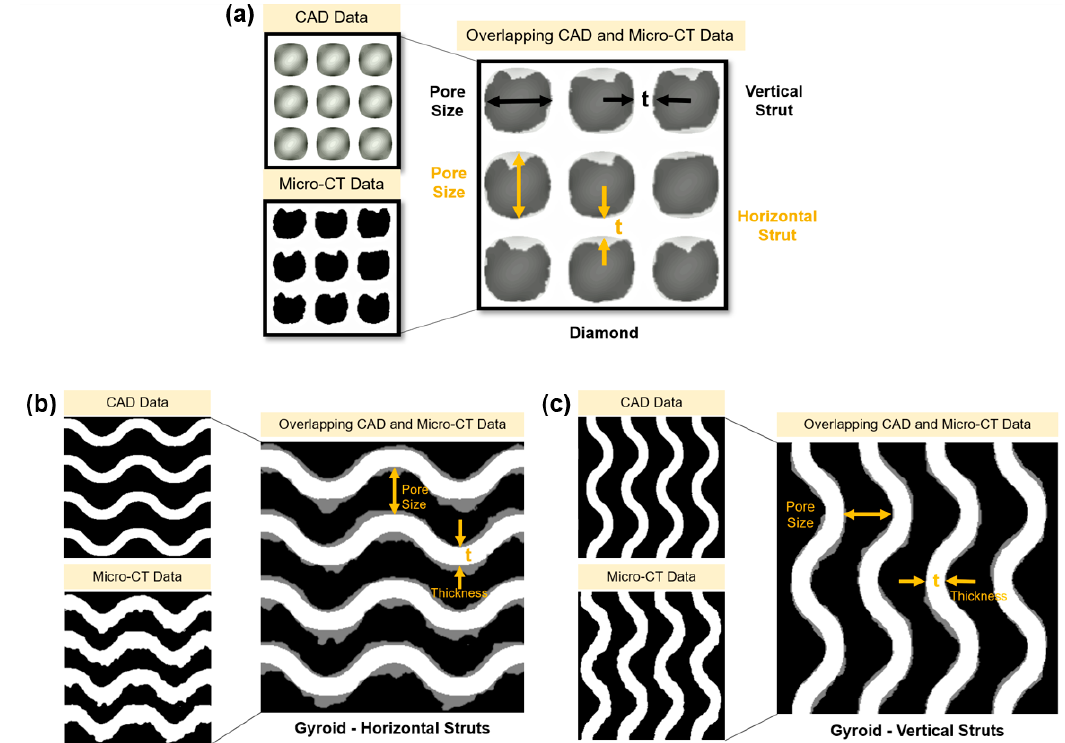
Figure 5. Overlapping CAD and micro-CT morphology data in vertical and horizontal struts orientations for ( a ) diamond scaffold, ( b ) gyroid (Horizontal Struts) scaffold and ( c ) gyroid (Vertical Struts) scaffold.